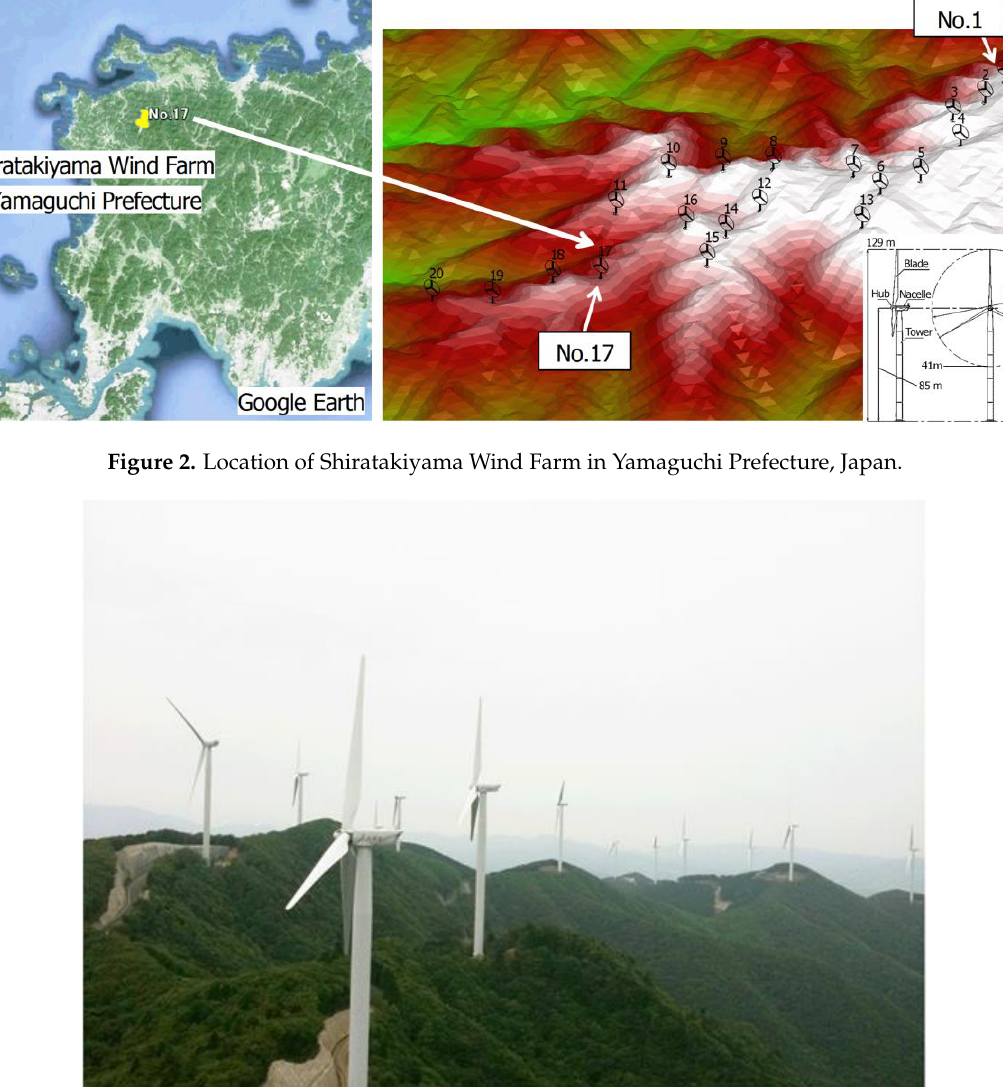
Figure 3. Photo of the Shiratakiyama Wind Farm taken from Wind Turbine No. 1.